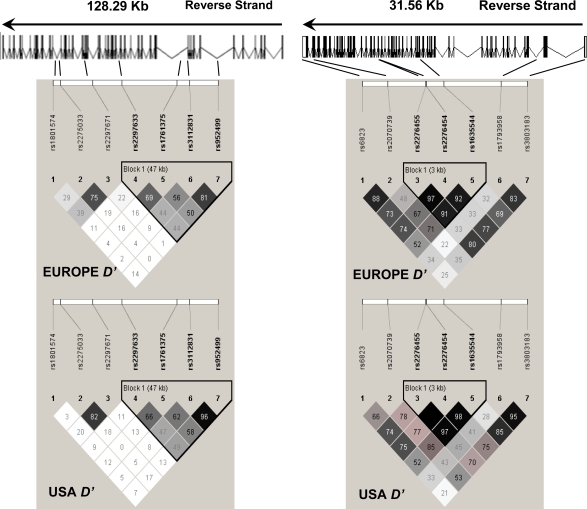
Gene structure and linkage disequilibrium plots for ABCA4 (left panel) and COL2A1 (right panel).Upper diagrams show positions of SNPs genotyped in relative to intron/exon structure of the gene. Lower diagrams show the linkage disequilibrium (D′) plots generated in Haploview (http://www.hapmap.org/) using data for each gene from the EMSCOT or NCCCTS cohorts as indicated. Linkage disequilibrium values (×100) between markers are indicated at the intercept of the two markers on the matrix. Where there is no value, D′ = 1 (i.e. 100). Haplotype blocks within each gene are outlined within the black triangles. The black (high) through grey to white (low) shading indicates the degree of confidence in the estimate of linkage disequilibrium between the markers. For the EMSCOT cohort, stepwise logistic regression analysis [50] of associations observed in the mothers (Online Supplementary Material, Text S1 plus Table S5) indicate that all of the association at ABCA4 is accounted for by rs2997633 and rs1761375, implying that a single etiological variant in strong linkage disequilibrium with these two markers may account for the association. At COL2A1, SNPs rs2276455, rs1635544 and rs3803183 all add significant main effects when compared to rs2070739, but rs2070739 does not add significant main effects to any one of these markers. SNPs rs2276455, rs1635544 and rs3803183 do not add significant main effects to each other. Once pairs of these markers are taken into the model, the third SNP does not add significant main effects. A single etiological variant in this haplotype block could account for the association with COL2A1. Neither SNP (rs2070739, rs3803183) that results in a non-synonymous amino acid substitution appears to be the primary functional variant.